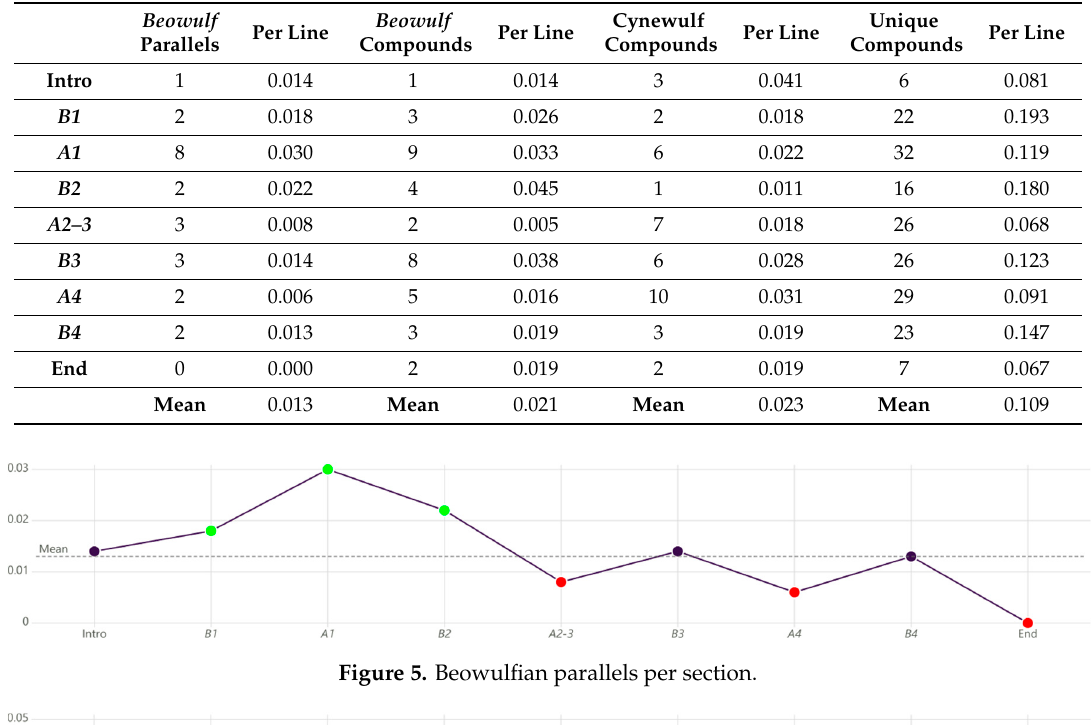
plot the “occurrence per line” scores from Table 2 against the mean for each metric. Scores deviating more than 20% from the mean for their group are flagged green (if above) or red (if below). Table 2. Distribution of word compounds in Andreas by section.